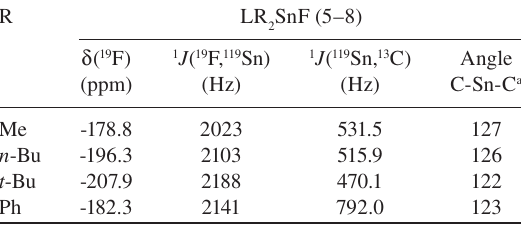
Table 2 Selected NMR parameters of 5 – 8